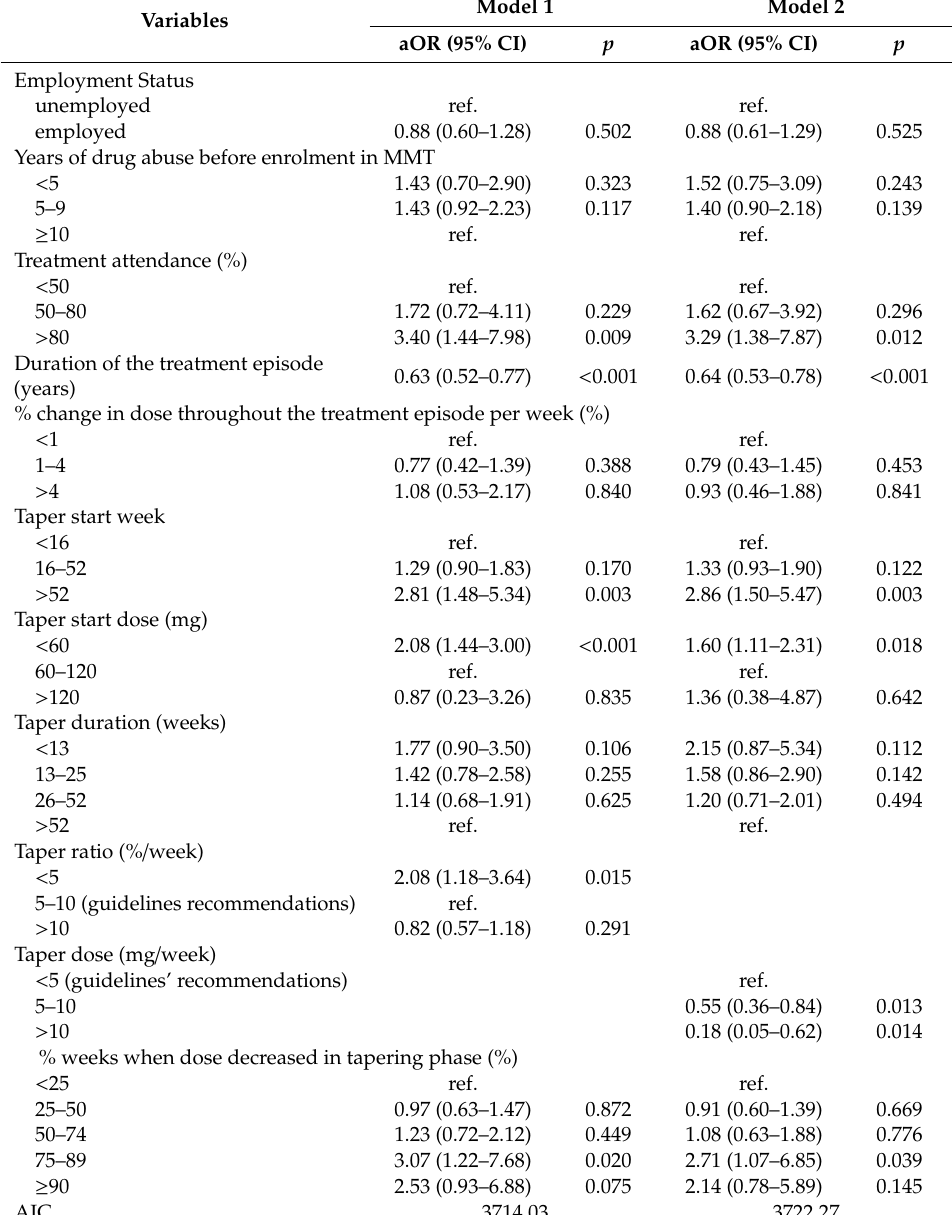
Table 3. Multivariable two-level logistic regression results: predictors of heroin